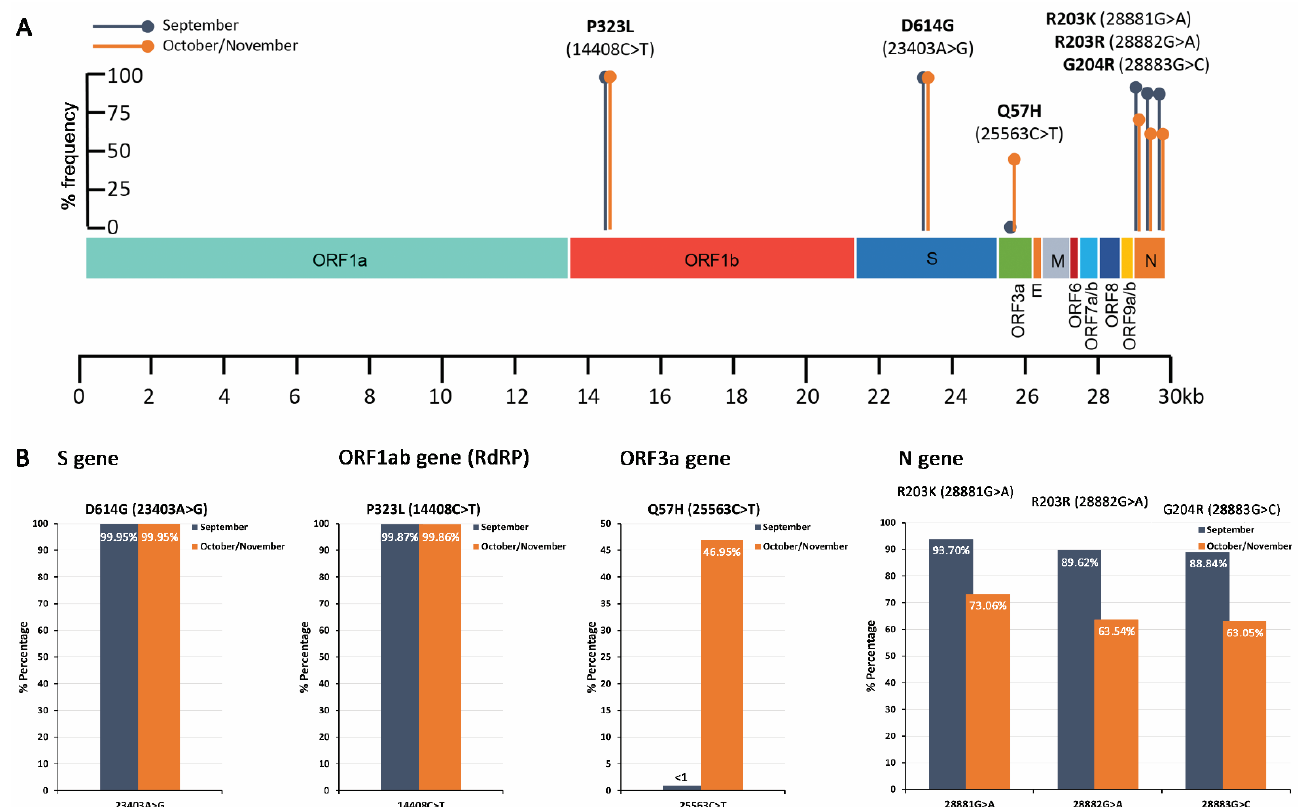
Figure 3. Schematic illustration on SARS-CoV-2 genomic map colored by genomic region ( A ) and bar plots ( B ) of the % frequency of D614G (S), P323L (RdRP), Q57H (ORF3a), R203K (N), and G204R (N) missense mutations in wastewater samples.